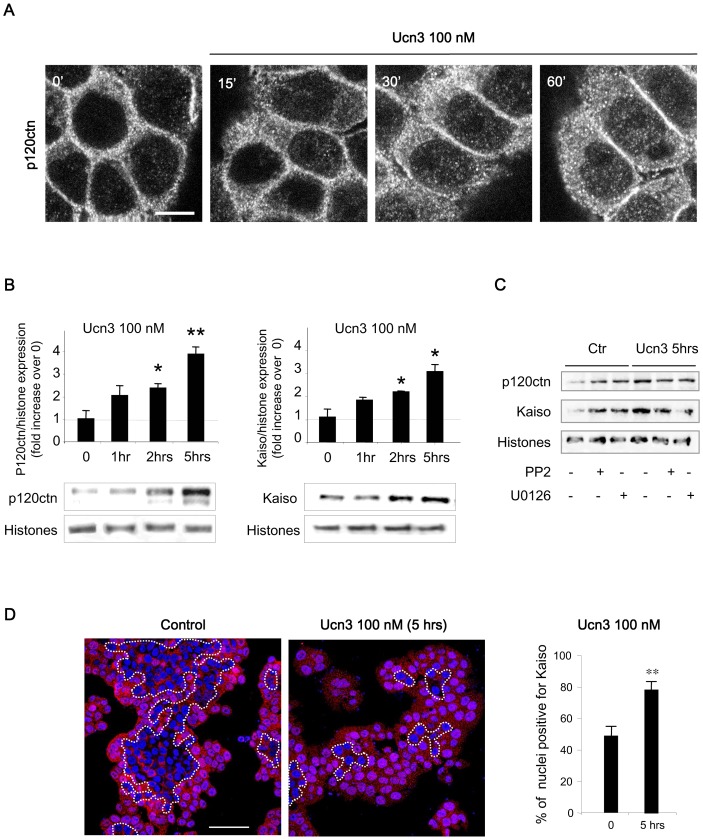
CRF2-mediated dissociation of AJ leads to nuclear shuttling of p120ctn and Kaiso.(A) Confocal analysis of p120ctn location in HT-29 cells pretreated with cycloheximide before Ucn3 treatment. Scale bar, 10 µm. (B) Immunoblot analysis of p120ctn and Kaiso protein expression in nuclear extracts from HT-29 cells treated or not with Ucn3 (expression was normalized to histones). (C) Effects of Src and MEK inhibitors (PP2 and U0126: 10 µM, 1 hr) on p120ctn and Kaiso protein expression in nuclear extracts from HT-29 treated or not with Ucn3. Expression was normalized to histones. (D) Confocal analysis of cellular distribution of Kaiso in HT-29 cells. Nuclei were stained with Topro3. Cells negative for nuclei labeling of Kaiso were circumscribed by a white dotted line. Scale bar, 60 µm.